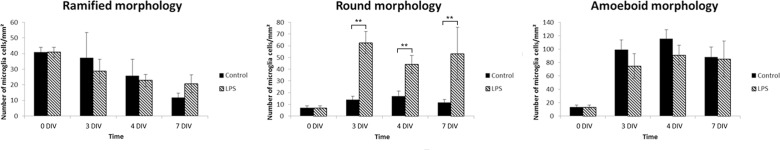
Quantification of microglia morphologies.Iba1-positive microglia was classified into three groups depending on morphology, including ramified, round and amoeboid. ANOVA analysis was performed for comparison between the LPS-treated groups and the control groups. Data are given as mean±StDev (n = 3-6/group), **p<0.01, compared to control at the corresponding time points.